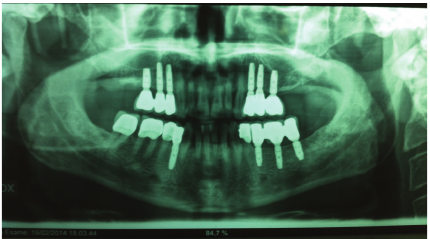
Figure 10: OPT radiographic situation 1 year after